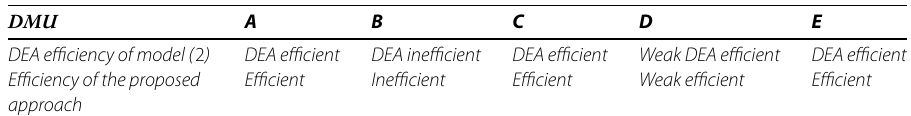
Table 2 The efficiencies of DMUs DMU A B C D E DEAefficiencyofmodel( 2 ) DEAefficient DEAinefficient DEAefficient WeakDEAefficient DEAefficient Efficiencyoftheproposed Efficient Inefficient Efficient Weakefficient Efficient approach